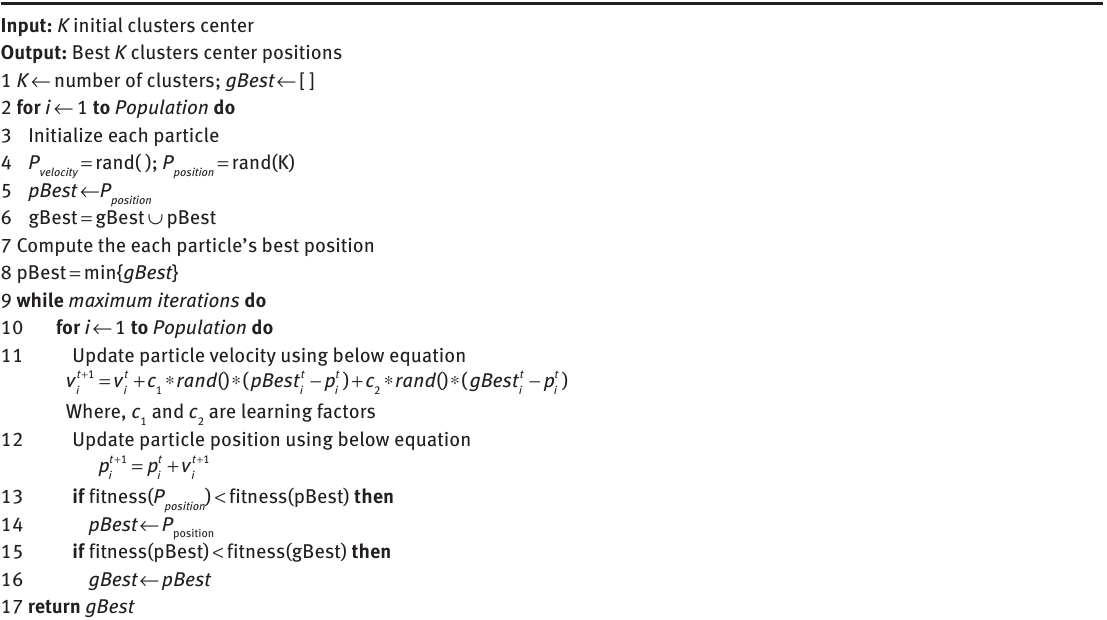
Algorithm 1: PSO-based